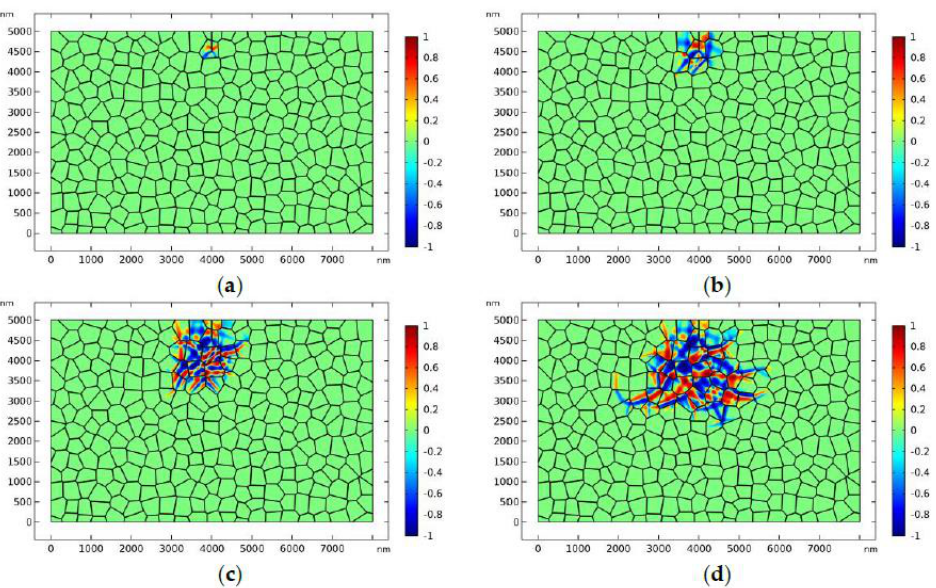
Figure 2. Stress-induced phase transformation around the static crack tip, where σ a = 90 MPa and T = 1360 K: the transformation patterns are exhibited by plotting η 1 − η 2 . Figure 2( a – d ) correspond to times: 0.01, 0.05, 0.2, and 0.4 μs , respectively.